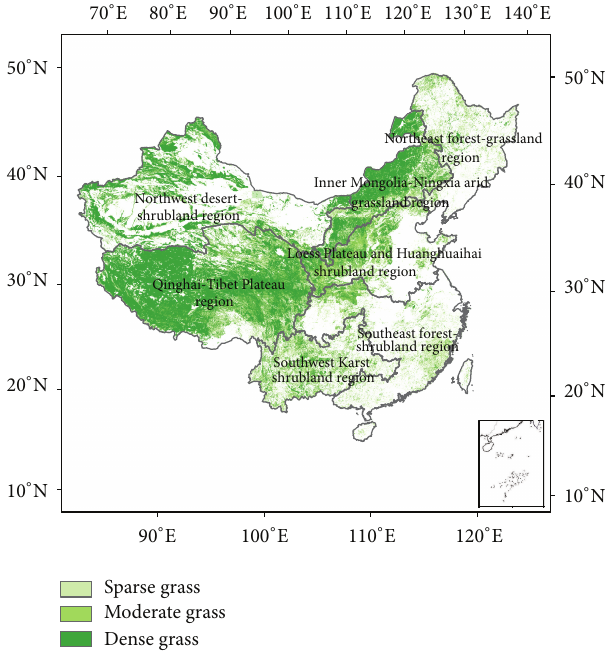
Figure 1: The Grassland distribution over grassland ecological- economic regions of China in year